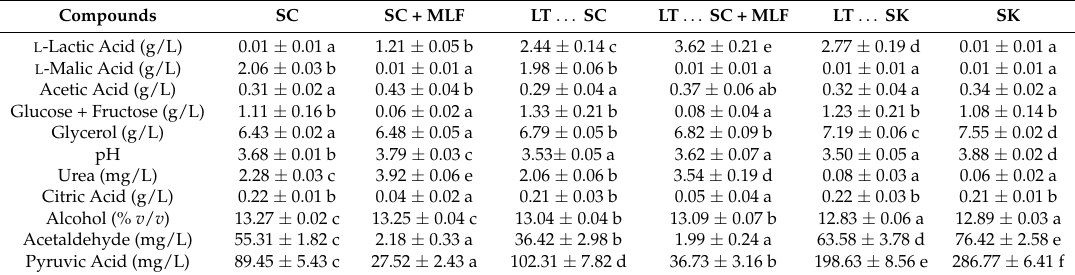
Table 1. Final analysis of fermentations from original must of Tempranillo grapes (see Experimental section): S. cerevisiae 88 alone (SC), sequential fermentation with S. cerevisiae 88 and L.